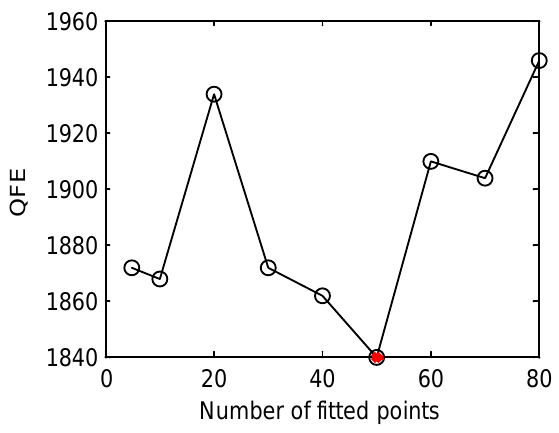
Figure 6. Fault diagnosis of fault 7 with parabola fitted initial values.